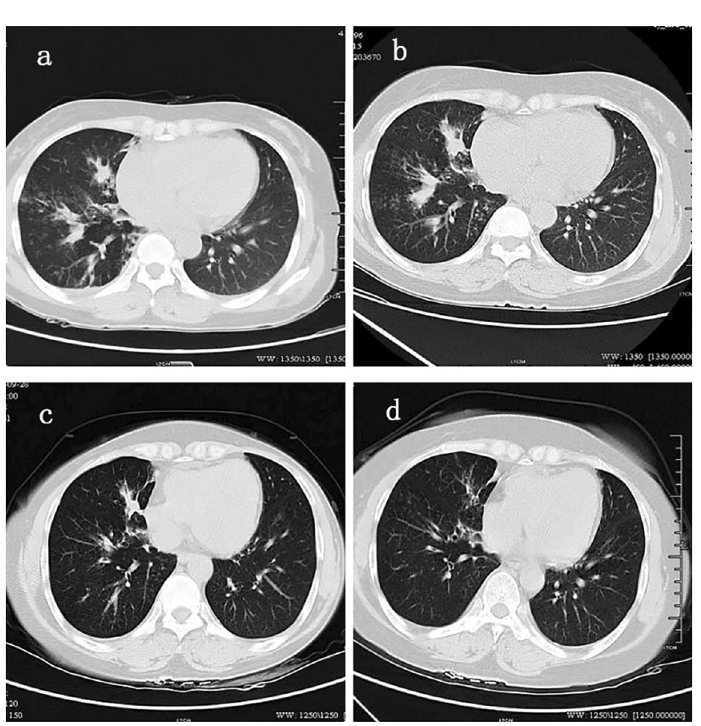
Figure 1. Patient underwent follow-up CT. ( a ) When this patient first came to our hospital, CT appeared as exudation with consolidation. ( b – d ) After treatment with glucocorticoids, the pulmonary consolidation significantly